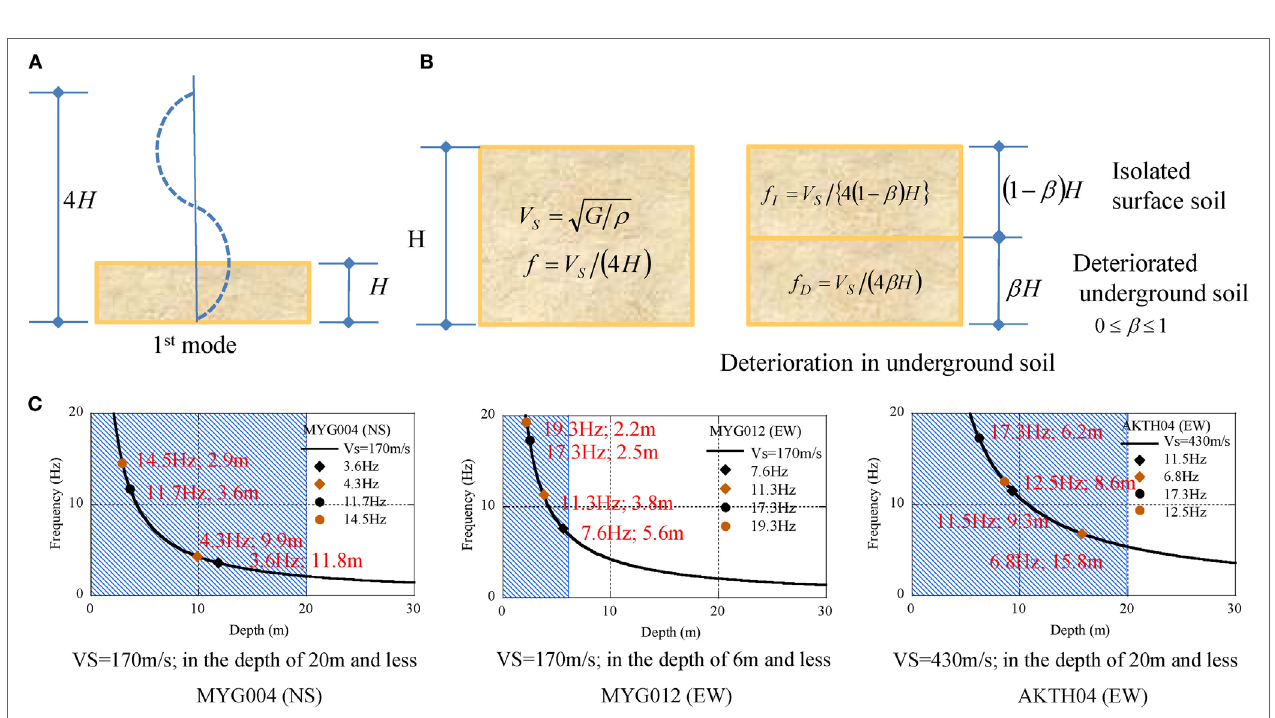
FigUre 13 | Modulation mechanism by deterioration of underground soil, (a) fundamental mode, (b) isolated surface soil, (c) evaluated depth of surface spoil.